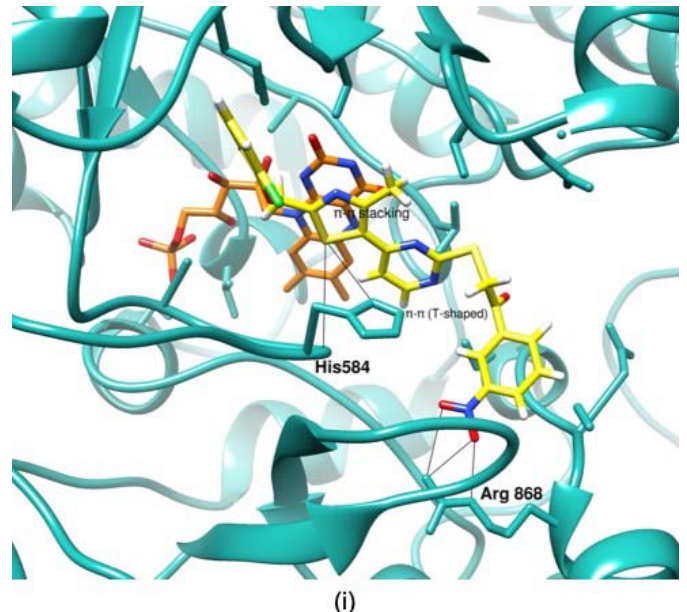
Figure 4. The 3D interaction plots for selected protein-ligand complexes ( a ) BTB14738, ( b ) BTB14516, ( c ) CD01000, ( d ) SEW02765, ( e ) HTS 07760, ( f ) HTS09453, ( g ) RH00608, ( h ) RJF01717, ( i ) SPB02705.